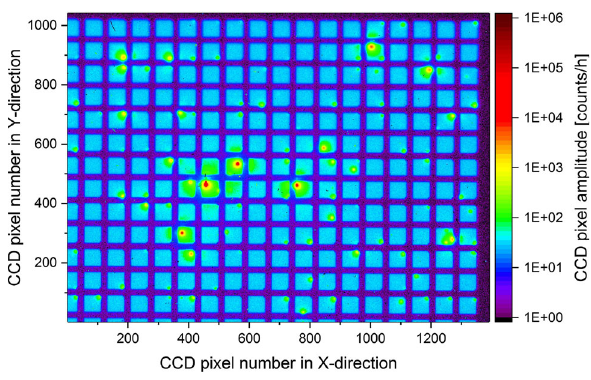
Fig. 1 Light emission image of the PM3350T STD at t exp = 4 h and Δ V = 5 . 4 V. Active areas of single micro-cells (blue) and hotspots within the micro-cells (red) are clearly visible. One CCD pixel corre- sponds to 0 . 42 µ m 2 of the SiPM area